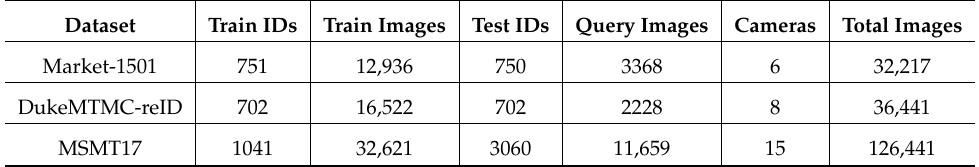
Table 1. Statistics of the datasets used for training and